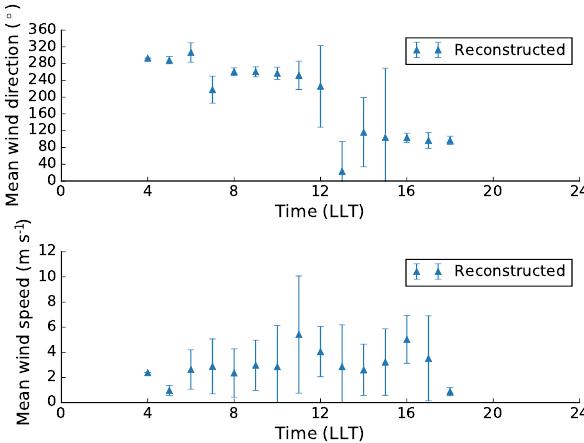
Figure 27. The reconstructed hourly wind directions and speeds for sol